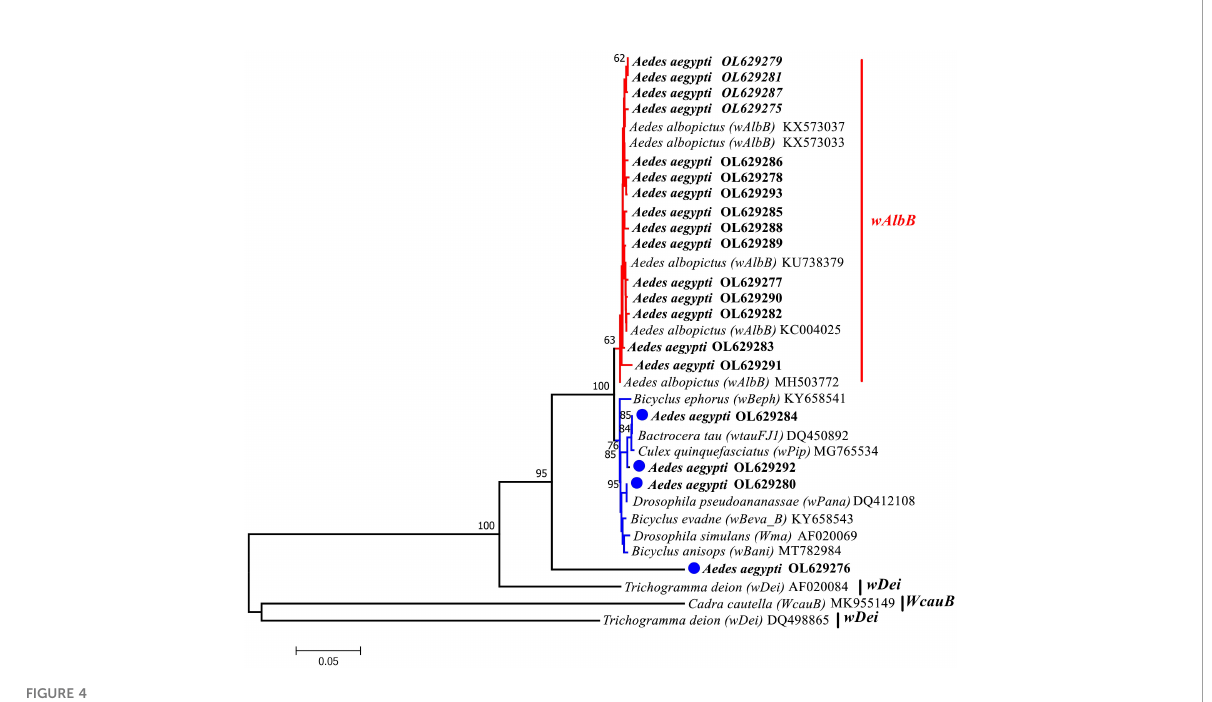
FIGURE 4 Phylogenetic tree analysis by the neighbor-joining method using the wsp gene (B supergroup primers: 183F,691R). The tree contains 34 nucleotide sequences. 19 from this study and 15from GenBank searches with Bootstrap values (1000 replicates) marked next to the branches. Taxa were tagged to obtain the host name of the Wolbachia strain and the ID in GenBank. the wsp sequences in this study all start with Aedes aegypti OL. OL629275 to OL629278 belong to JHGZ, Xishuangbanna prefecture. OL629279 and OL629280 belong to JHFZ, Xishuangbanna prefecture. OL629281 and OL629282 belongs to JHML, Xishuangbanna prefecture. OL629283 and OL629284 belong to JHGL2, Xishuangbanna prefecture. OL629285 and OL629286 belong to DLAA, Xishuangbanna prefecture. OL629287 and OL629288 belong to DLXX, Xishuangbanna prefecture. OL629289 belongs to JHJL, Xishuangbanna prefecture. OL629290 to OL629292 belong to JGLS, Dehong prefecture.OL629293 belongs to RLJK, Dehong prefecture. The reference sequences used are shown in